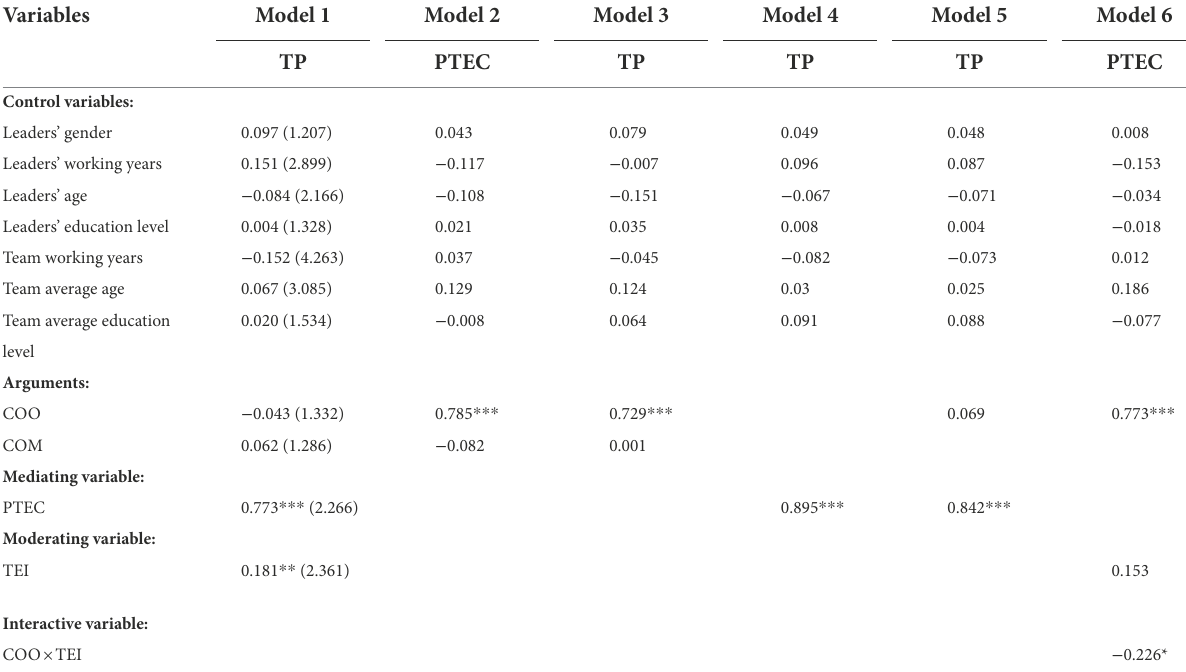
TABLE 3 Hierarchical regression